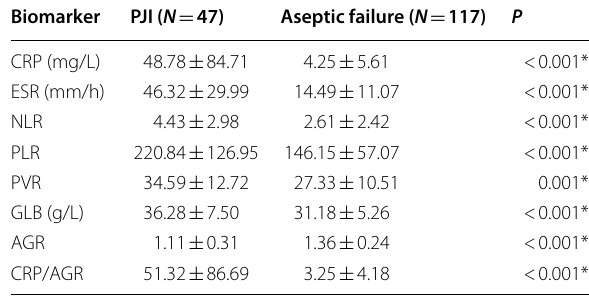
Table 3 Values of the tested biomarkers in the PJI and